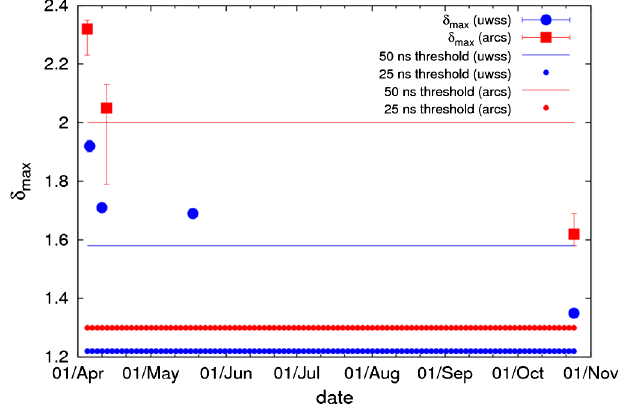
FIG. 26. Approximate time evolution (from April to in the uncoated warm straight October 2011) of (cid:1) max sections (chamber radius 40 mm) as well as in the arc dipoles (chamber half apertures 22 (cid:2) 18 mm ) at the LHC at injection energy. The lowest values reachable with scrubbing correspond to the 25-ns multipacting threshold at 3.5 TeV. The first injection of a beam with 25-ns bunch-spacing beam took place on 29 June 2011. The error bars refer to different locations (in the case of straight sections they are included in the size of the